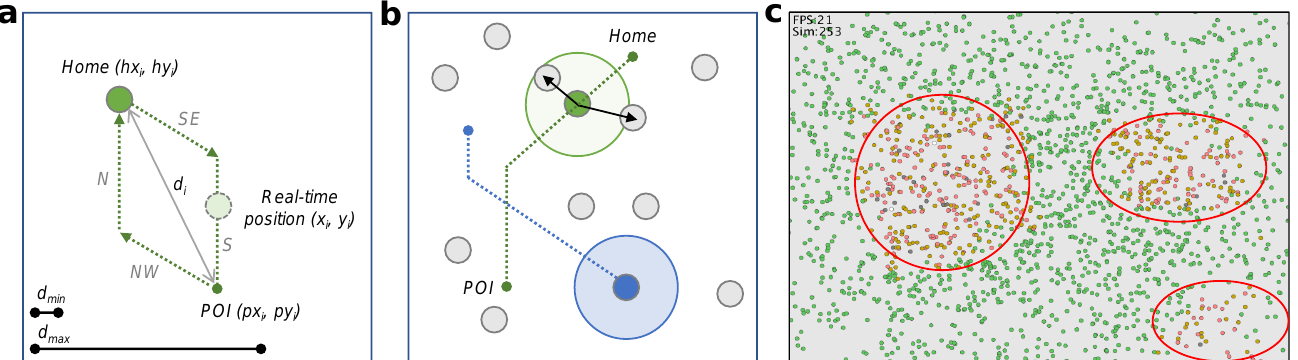
Figure 2. Overview of the agent-based model. ( a ) The relationship between an agent’s home, POI and real-time locations. An agent will move to a POI (and back home) based on a combination of 45-degree directions followed by orthogonal movement. In the lower-left corner, the minimum and maximum POI distances are illustrated relative to the exemplified simulation space. ( b ) Multiple agents in the simulation space, of which two are highlighted with green and blue. Each agent moves independently to its POI and back. Each infected agent has an infection radius around which it can infect other susceptible agents based on the infection rate. ( c ) A screenshot from the simulation tool developed in Processing for educational purpose. Here, three initial infection clusters (orange and red dots) emerge and spread out based on each agent’s mobility to engulf a larger